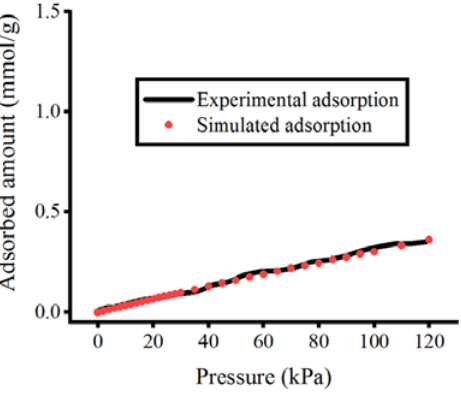
Figure 2. Comparison of experimental [22] and simulated adsorption isotherms of N 2 in CALF-20.